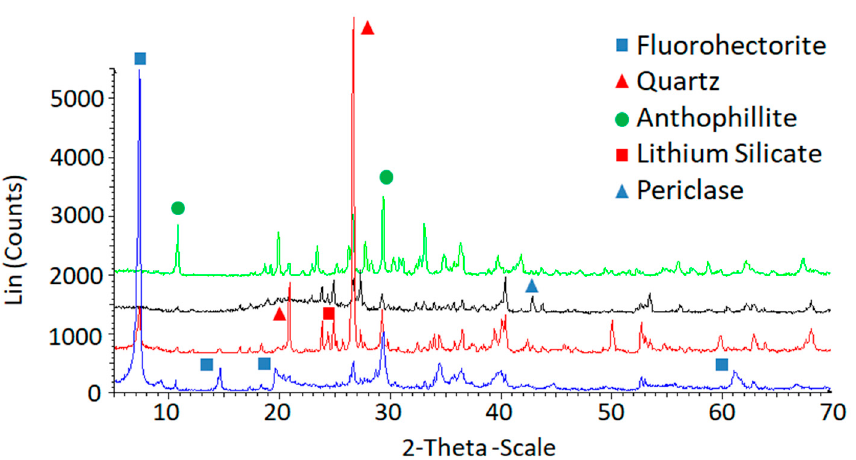
Figure 1. XRD patterns of FH800s samples synthesized at 800 °C for 3, 6 and 12 and 24 h from bottom to top.